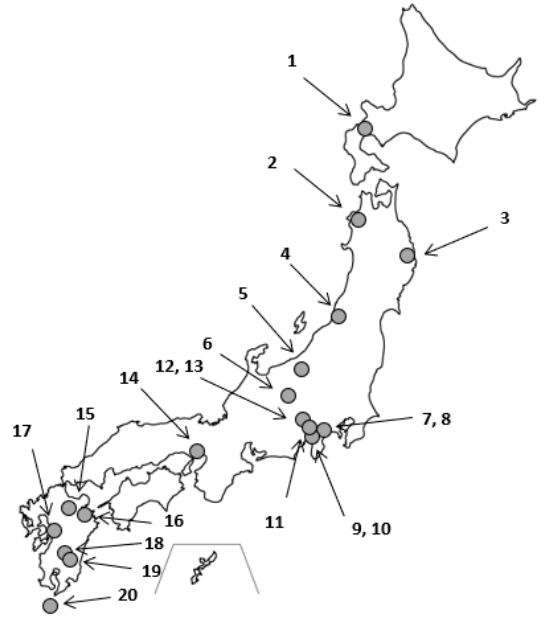
Figure 2. Locations of 20 bottle water samples.